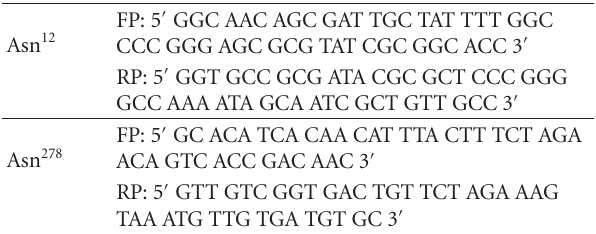
Table 1: Oligos used for carrying out SDM of wild type (native) rPA